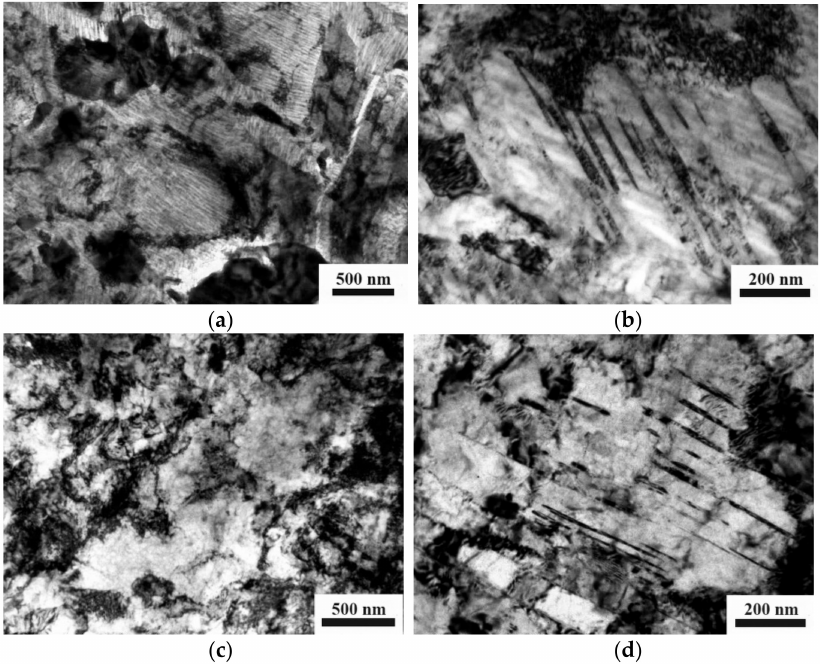
Figure 8. TEM microstructure of the TWIP steel processed by ECAP + rolling at temperatures of 375 ◦ C ( a , b ) and 500 ◦ C ( c , d ) taken at different